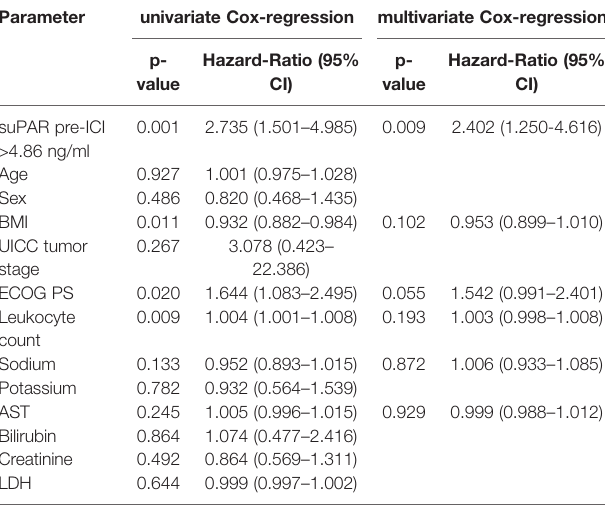
TABLE 4 | Uni- and multivariate Cox-regression analysis for the prediction of overall survival. univariate Cox-regression multivariate